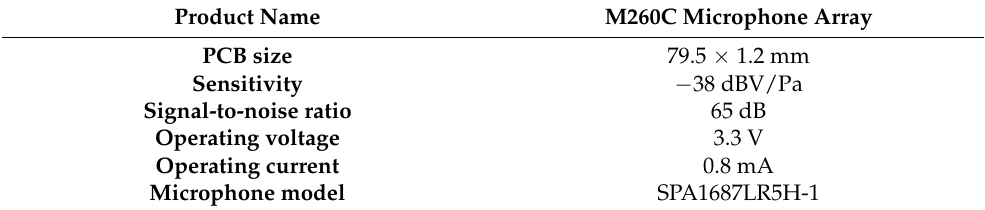
Table 1. Hardware parameters of the M260C Microphone Array.